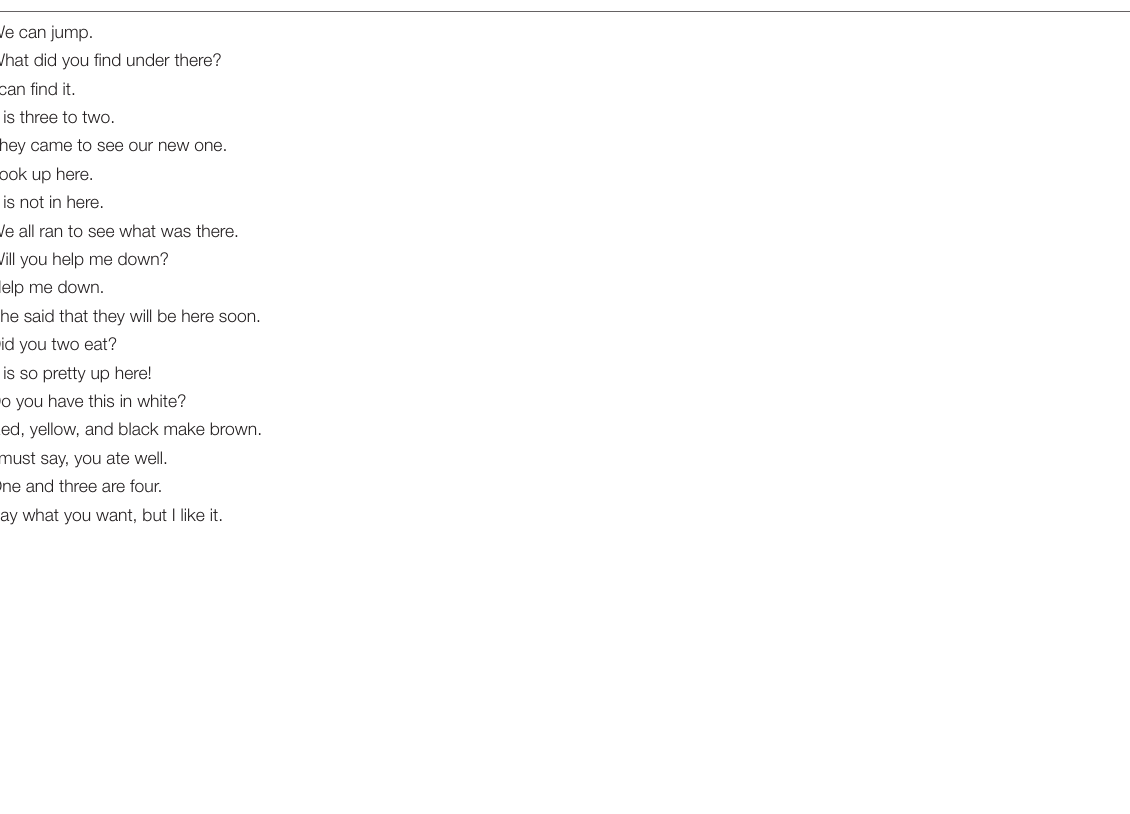
TABLE B | Sentences for Experiment